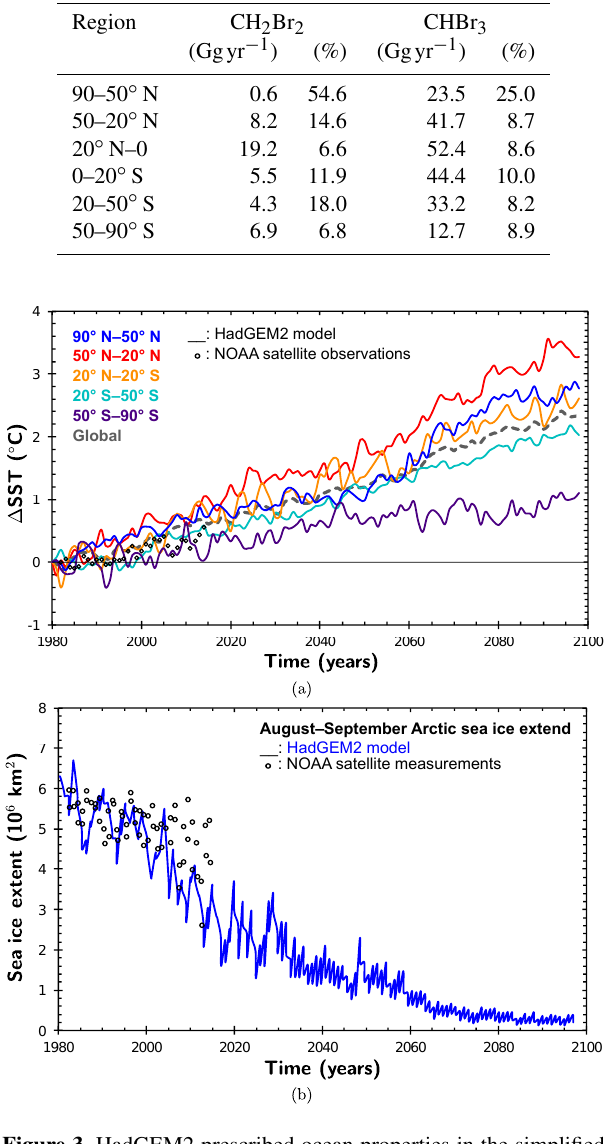
Figure 3. HadGEM2 prescribed ocean properties in the simplified chemistry simulations compared to National Oceanic and NOAA Optimum Interpolation (OI) V2 fields (Reynolds et al., 2002). (a) Change in sea surface temperature for different latitude bands. Global average is shown as dashed gray line. (b) Arctic sea ice ex- tend in August and